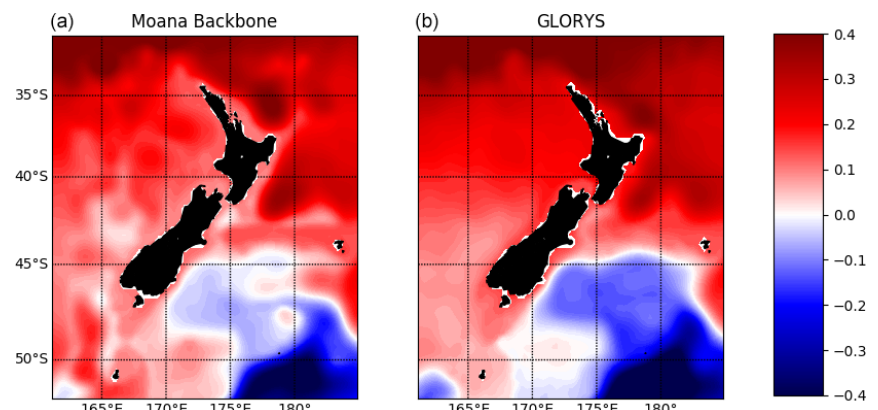
Figure 2. Temporal mean SSH (m) from the free-running Moana Ocean Hindcast (a) and the data-assimilating GLORYS (b) simulations. The general patterns of the SSH are reproduced by both models.